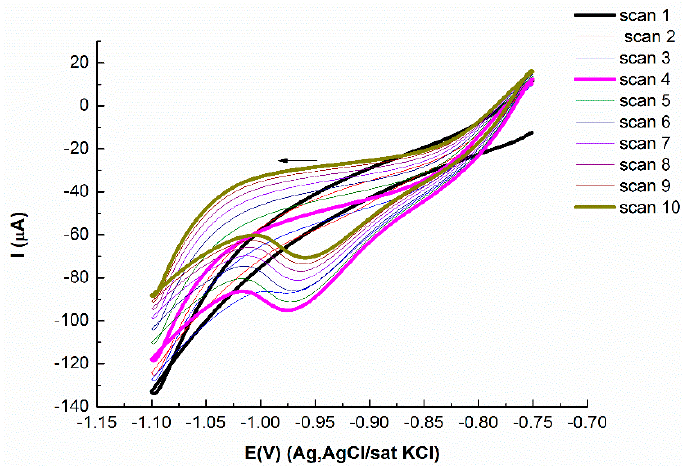
Figure 4. Consecutive cyclic voltammograms of 1 mM SeO 32 − on Mo ad /Ag(111) in a pH 9.2 ammonia buffer solution, different end scan. The scan rate is 50 mV·s − 1 .